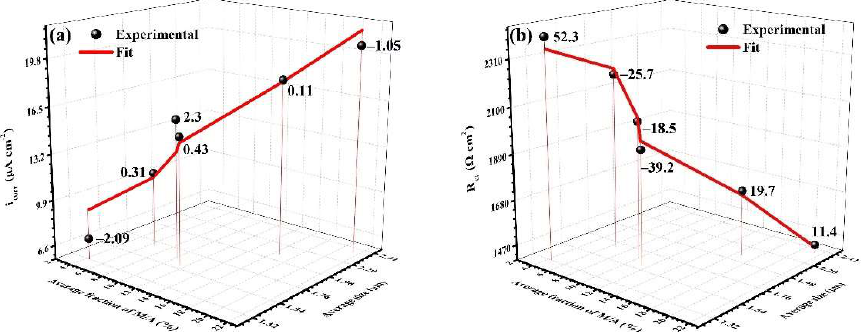
Figure 21. Fitting results of the functional relationship between i corr ( a ), R ct ( b ) and fraction of M/A constituents and average size.